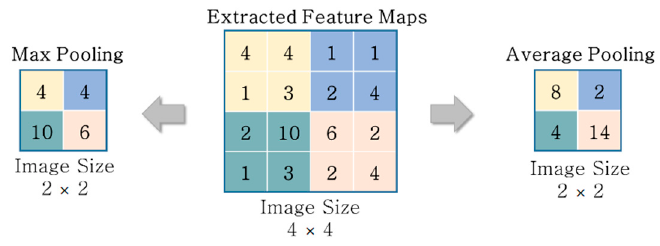
Figure 2. Examples of maximum and average pooling.